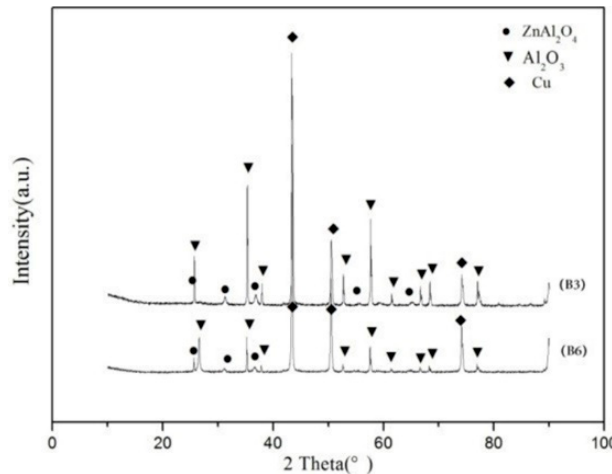
Figure 5. XRD spectrum of Al 2 O 3 /30glass/30Cu f .